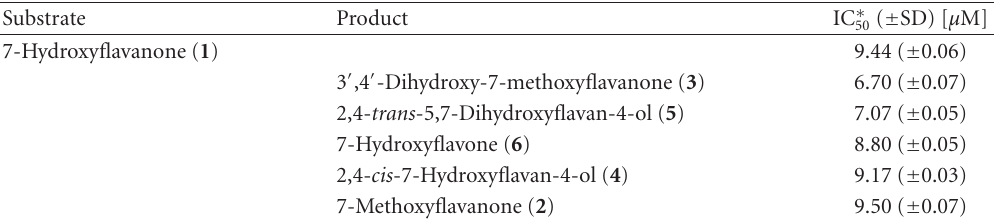
Mean values of IC 50 calculated as an average of at least three